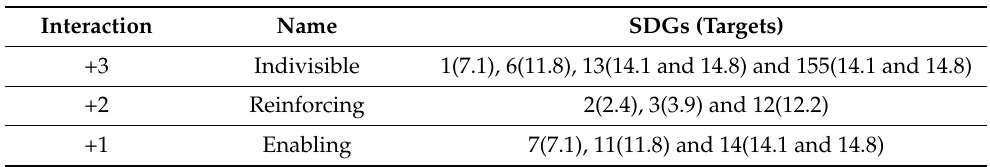
Table 1. Positive interactions between the United Nations Sustainable Development Goals (SDGs) and their targets and Swedish wetland ecosystems